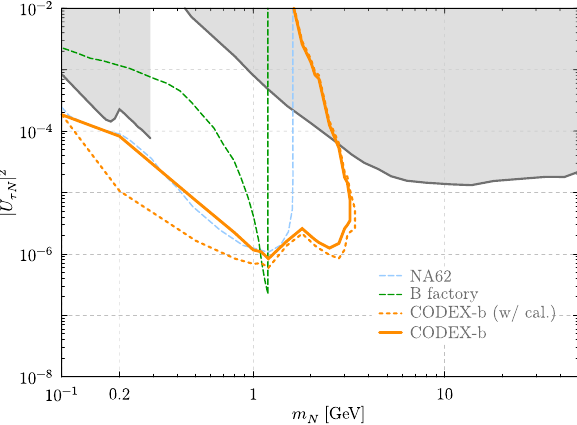
Fig. 35 Projected sensitivity of CODEX-b to Dirac heavy neutral lep- tonsfor U τ N (cid:9) U eN , U μ N foratrackingdetectoronly(solid)compared to an optimistic case (dashed) with a calorimetercapable of reconstruct- ing the N → νπ 0 final state, assuming the background differential flux of single π 0 ’s is negligible or reducible of appearing tracks induced from the muon background is ∼ 10 − 2 per 300 fb − 1